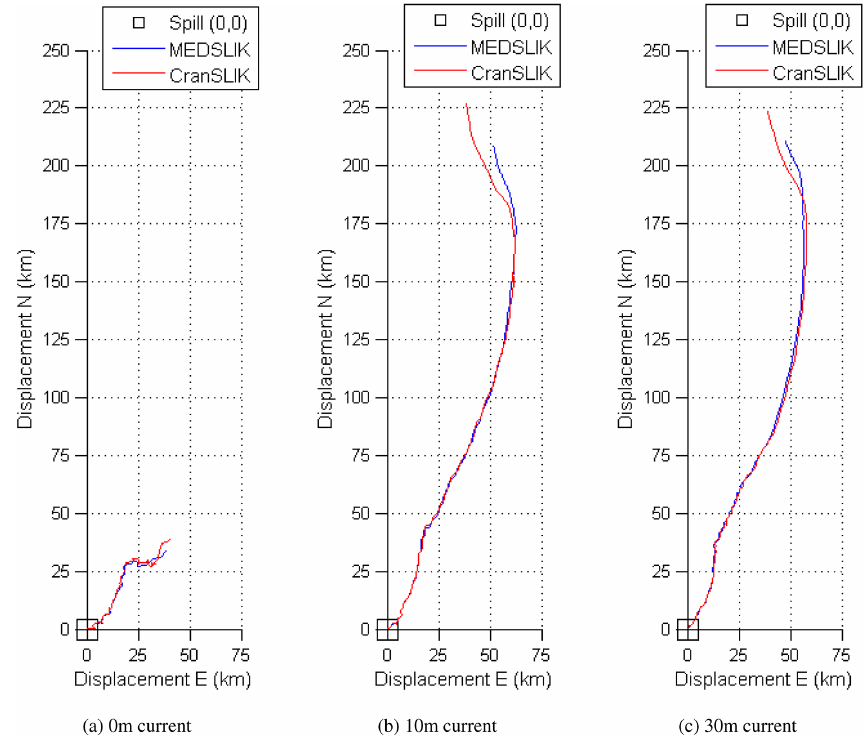
Figure 8. Centre of mass trajectory forecasts (hours 1–600) for the Lebanon case using the current at different depths as the advective current.